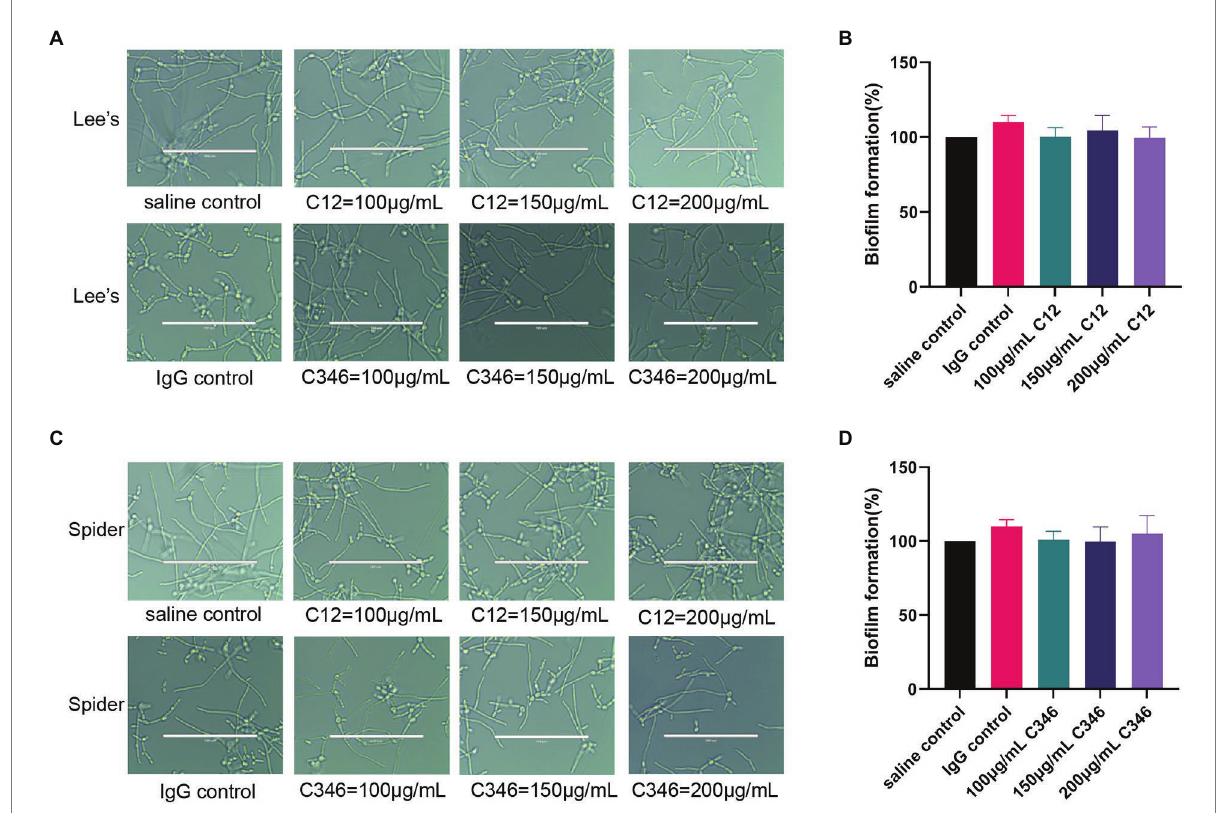
FIGURE 5 No obvious inhibitory effects of anti-rPmt4p mAbs C12 and C346 on hyphal growth or biofilm formation. Exponentially growing C. albicans SC5314 cells were transferred to Lee’s liquid medium (A) or Spider medium (C) , followed by co-incubation with different concentrations of mAbs. The cellular morphologies were photographed after incubation at 37 ° C for 3 h. Scale bar = 100 μ m for (A,C) . Exponentially growing C. albicans SC5314 cells were transferred to RPMI1640 liquid medium in a 96-well plate for 90 min, followed by addition and incubation for 24 h with mAbs, C12 (B) or C346 (D) . Biofilm formation was evaluated by the XTT reduction assay. The results are presented as the percentage compared to the biofilm formed in the saline control group. Data in (A,C) are representative of three independent experiments. Data in (B,D) are expressed as means ± SD ( n =